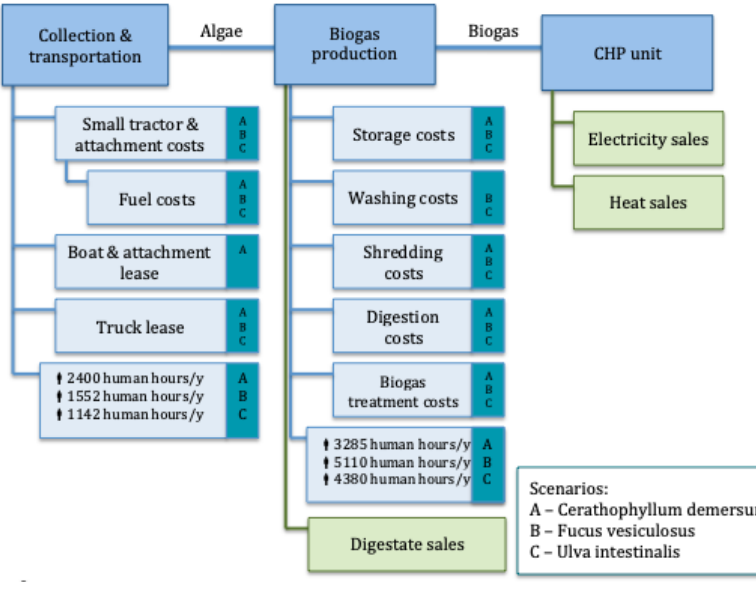
Fig. 2. Main operational